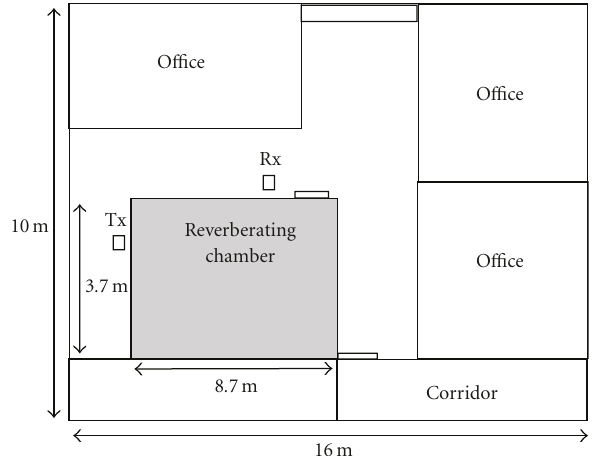
Figure 12: Measurement environment layout of the measurement campaign 2.